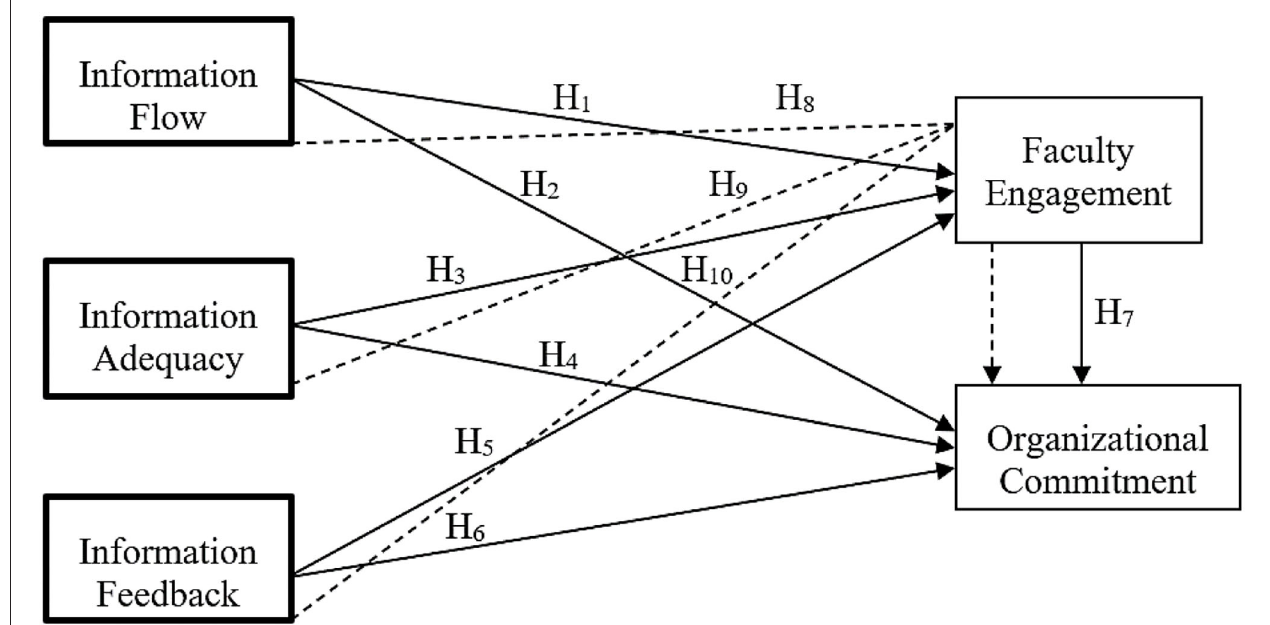
FIGURE 1 | Theoretical